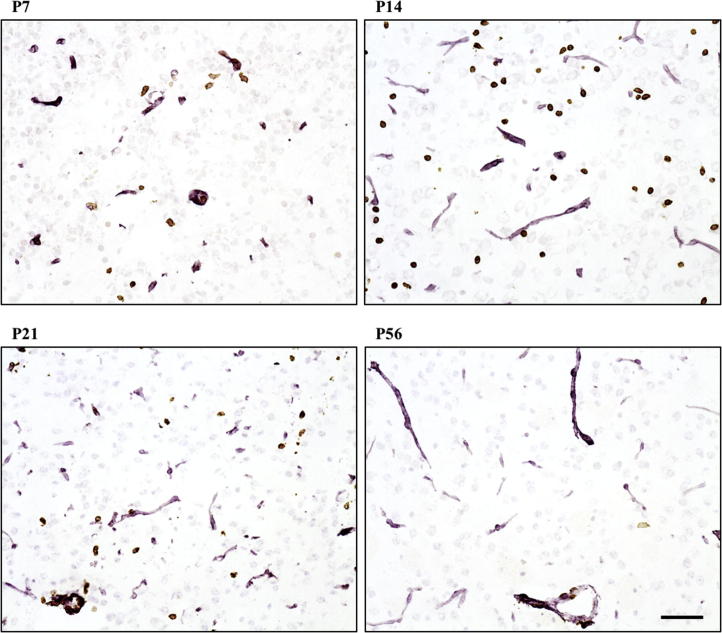
Recruitment of neutrophils to the brain 4 h after intracerebral injection of 1ng IL-1β during postnatal period. Photomicrographs show neutrophils (brown; anti-neutrophil serum) and vessels (pink; laminin) in the striatal injection site 4 h after the intracerebral injection of 1ng IL-1β at P7, P14, P21 and P56. These not only show that more neutrophils were present in the brain, but also that more cells were able to migrate into the parenchyma at P14. Scale bar = 50 µm.